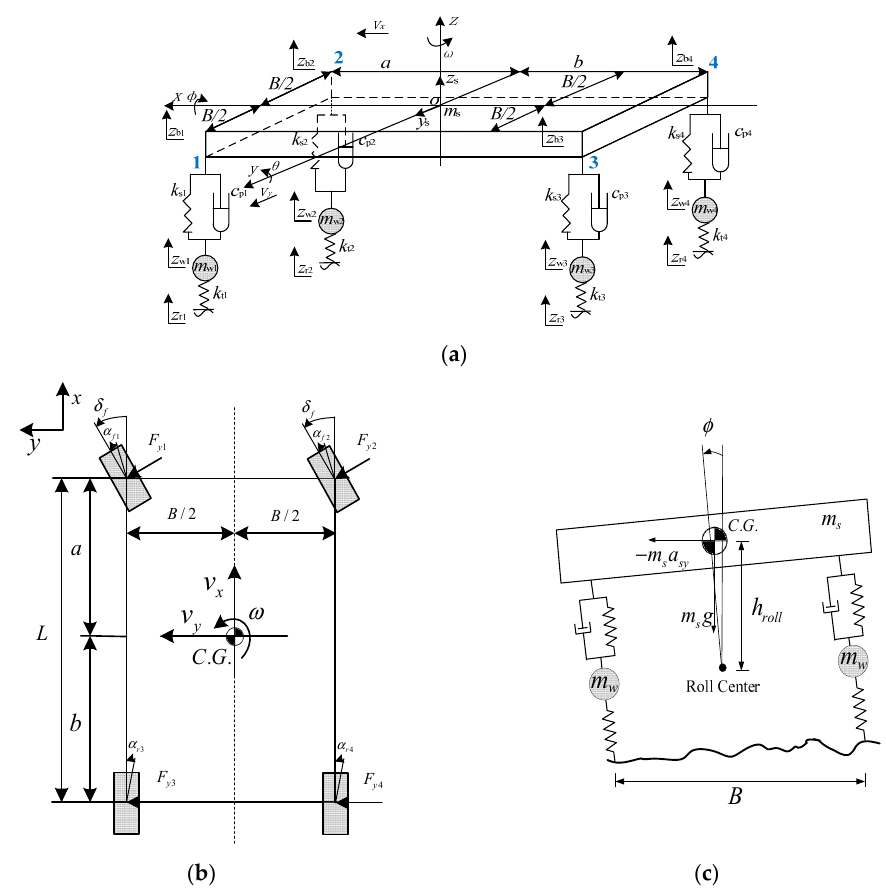
Figure 7. 9-DOF vehicle dynamics model. ( a ) Full-car dynamics model. ( b ) Lateral dynamics model. ( c ) Roll dynamics model. Table 3. Description of symbols used for 9-DOF full-car dynamics model.